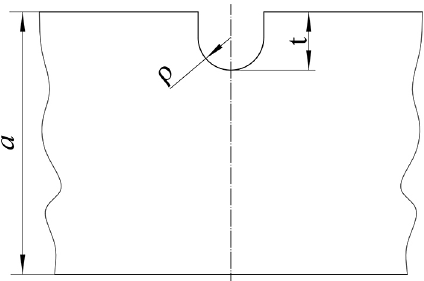
Figure 1. A steel plate with an incision.